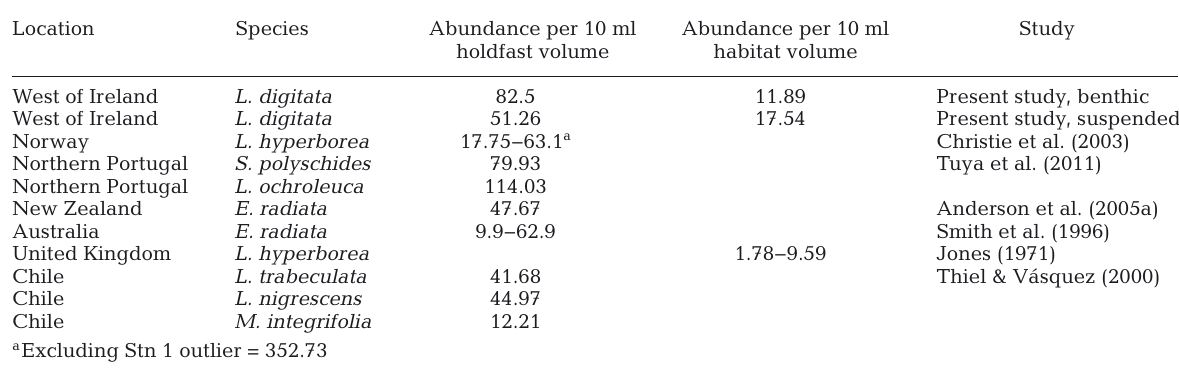
Table 4. Comparison of mean abundance per 10 ml of holdfast volume or habitat volume across a number of studies from varying locations and varying kelp species ( L .: Laminaria , S .: Saccorhiza , E .: Ecklonia , M .: Macrocystis ). Range values given when differential samples from species, location and other factors were